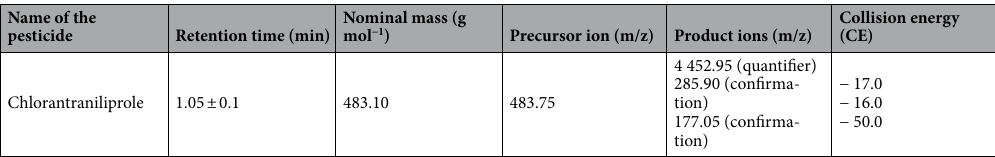
Table 1. LC–MS/MS parameters for chlorantraniliprole.